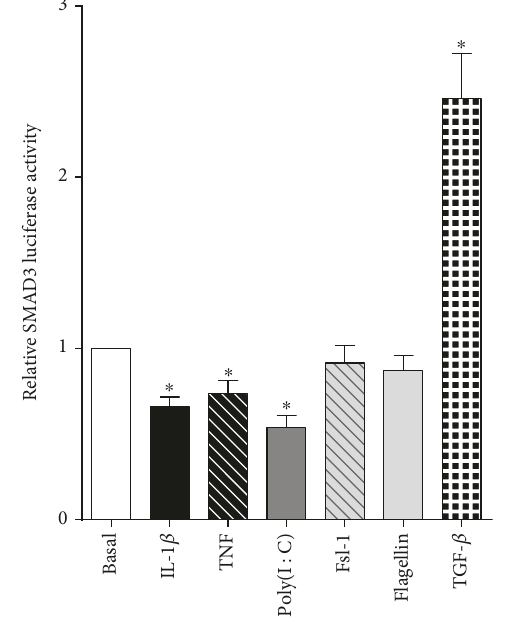
Figure 2: E ff ect of proin fl ammatory mediators on SMAD3 activity. Human primary myometrial cells, obtained from women at term in the absence of labour, were cotransfected with 300 ng SMAD3-luc reporter construct for 48h, then treated for an additional 24h with 1ng/ml IL-1 β , 10ng/ml TNF, 5 μ g/ml poly(I:C), 250ng/ml fsl-1, 1 μ g/ml fl agellin, or 10ng/ml TGF- β ( n = 5 patients per treatment). Promoter activity is expressed as a ratio of luciferase activity of the SMAD3 reporter under basal conditions. Each bar represents the mean ± SEM. ∗ P ≤ 0 05 vs. basal (paired sample comparison).